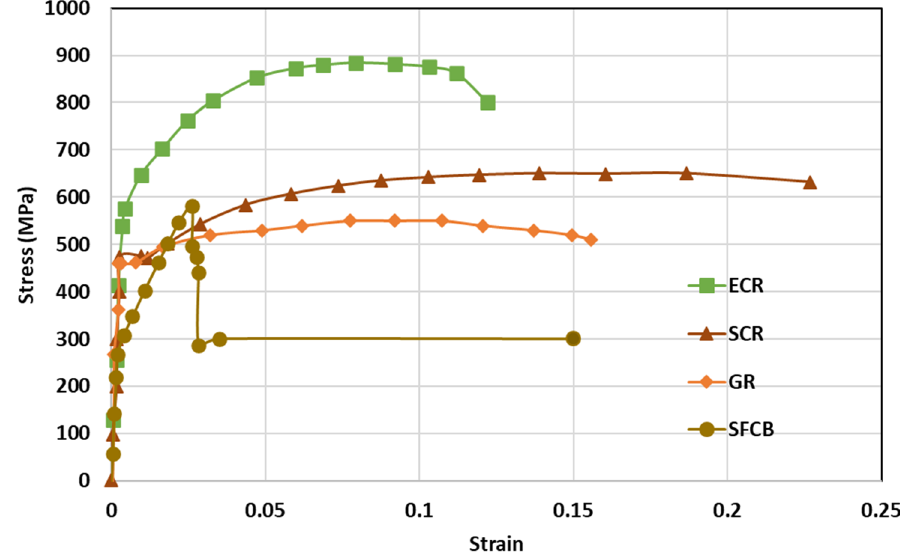
Figure 4. Comparison of typical tensile properties of GR [70], ECR [27], SCR [74], and SFCB [75].